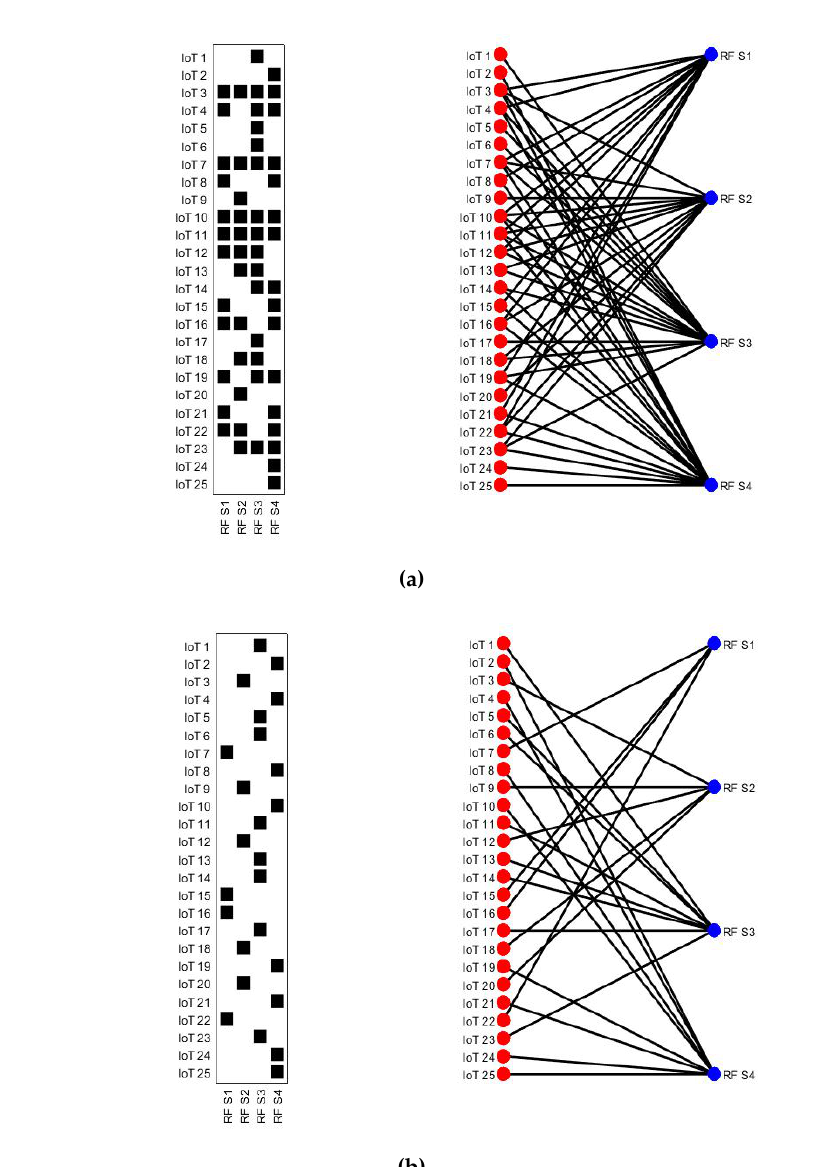
Figure 3. Association of IoT devices and RF sources. ( a ) Initial association using bipartite graph; ( b ) Optimal association by extracting biclique